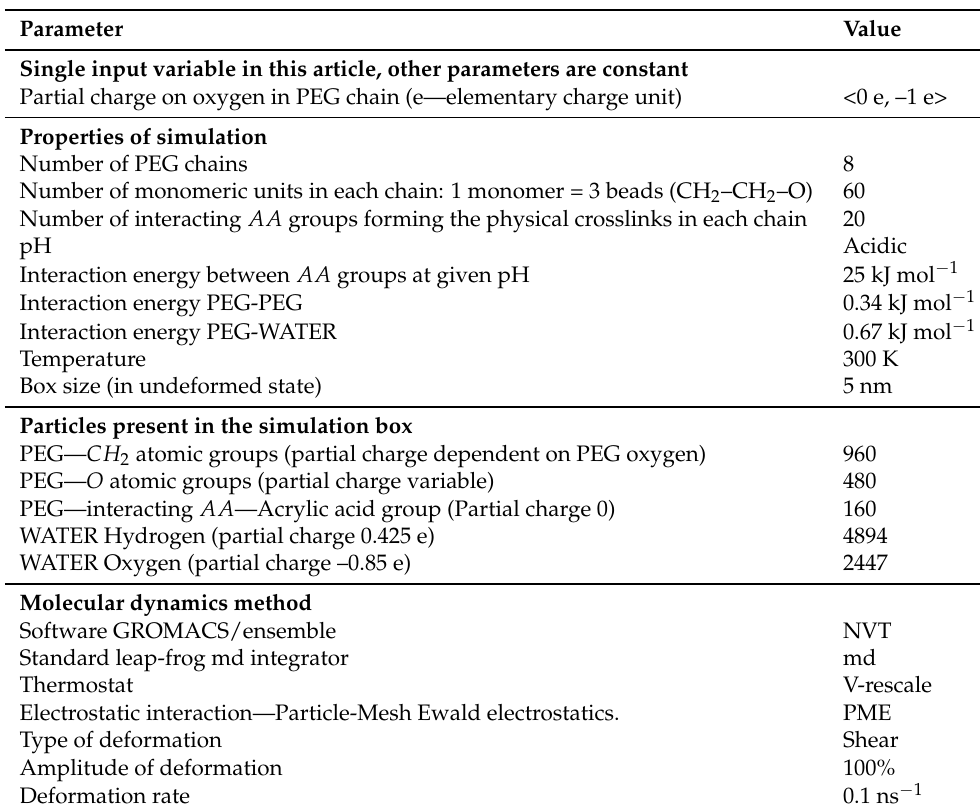
Table 1. List of parameters of